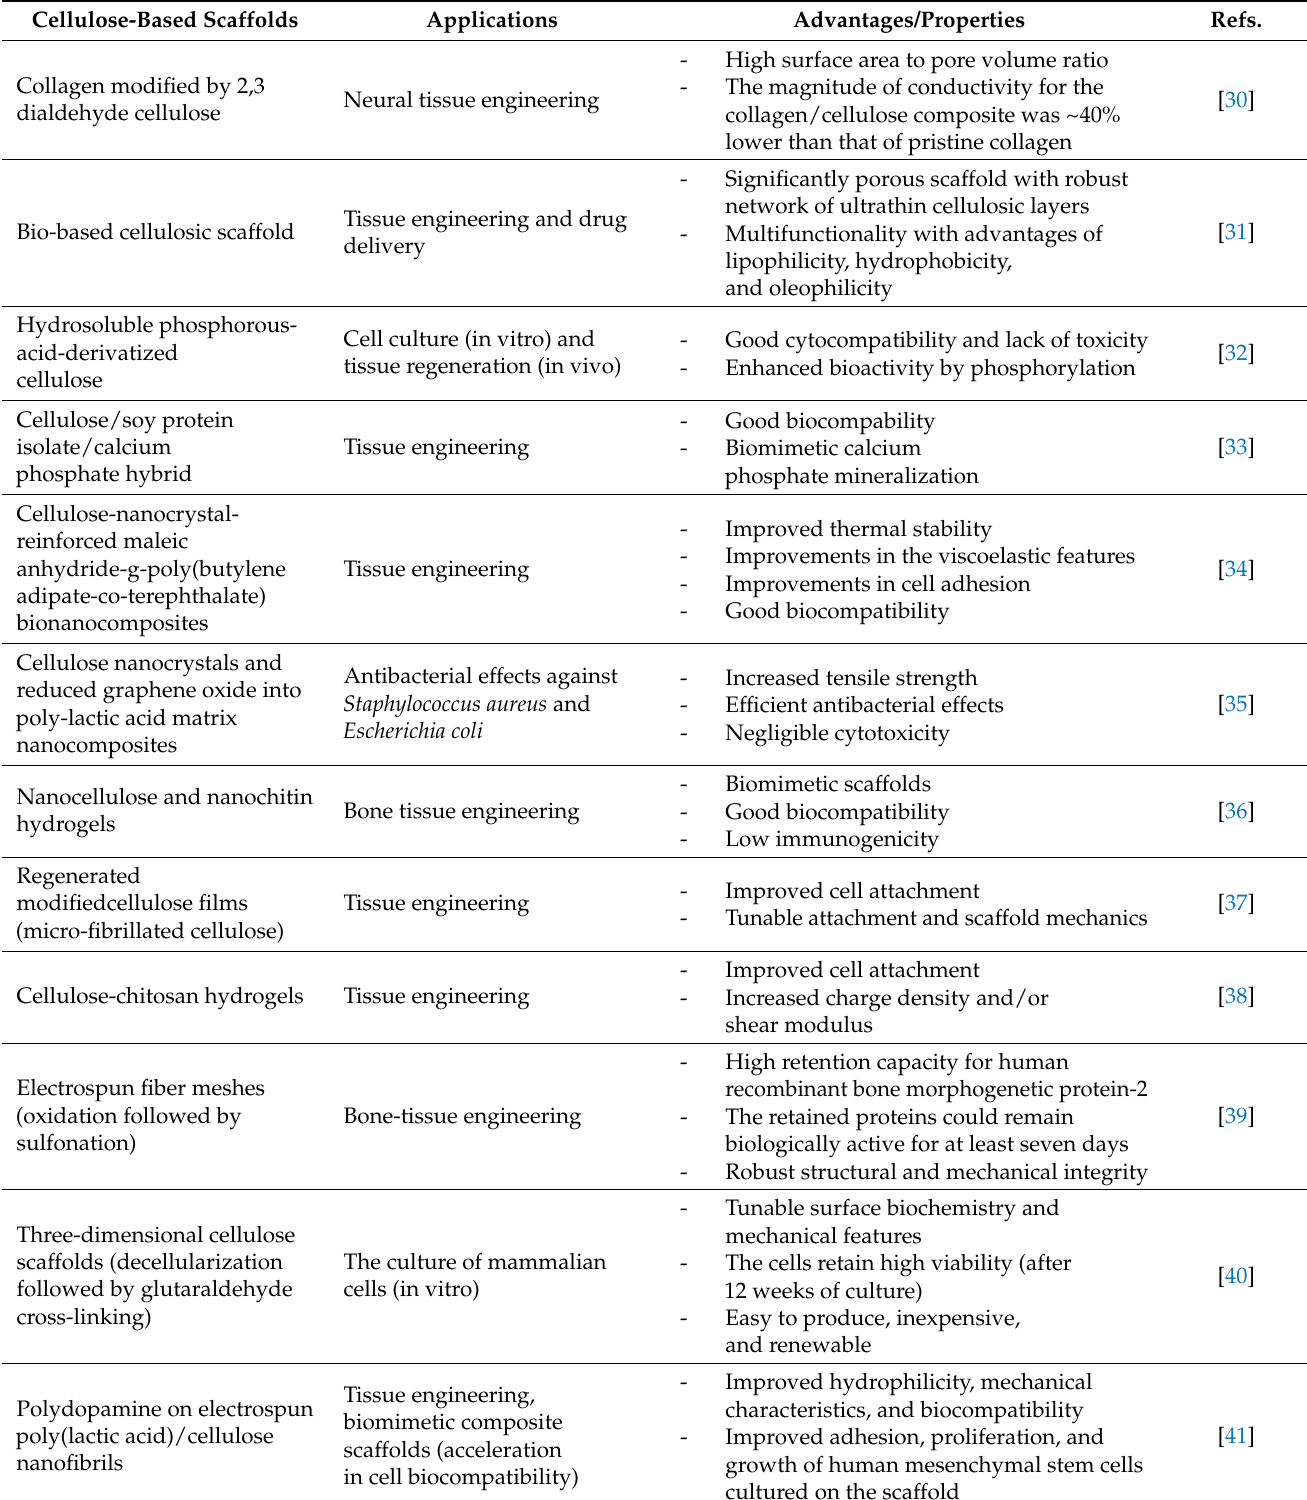
Table 1. Some selected examples of cellulose-based scaffolds with tissue engineering